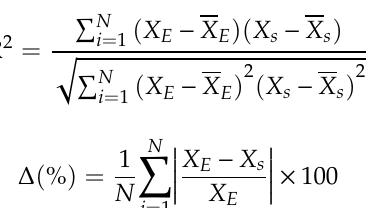
Figure 18. A comparison between the experimental and FE simulation results for the X DRX after hot working.